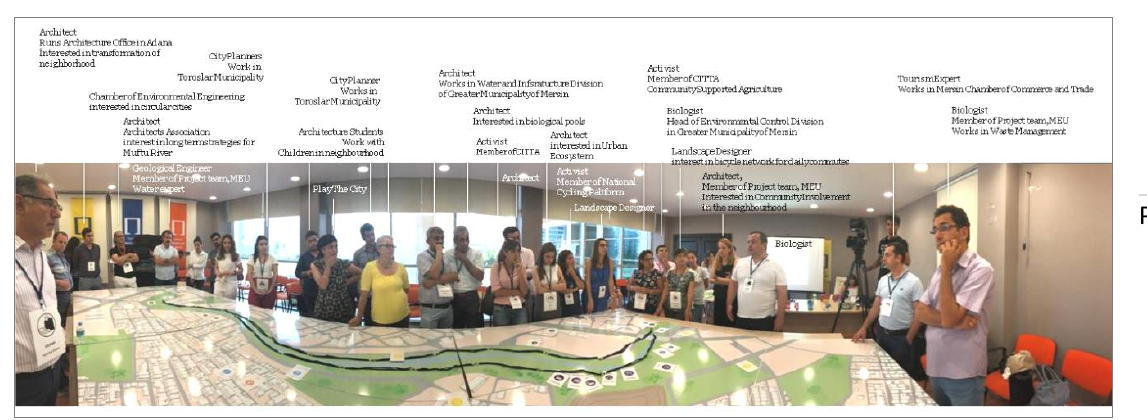
Figure 7 Participants in the first game session